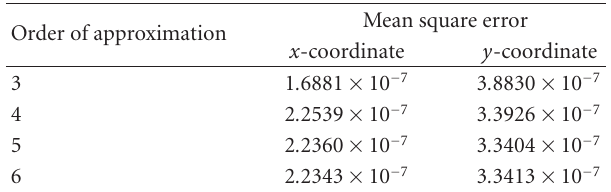
Table 1: Mean square error in x -coordinate and y -coordinate for varying approximation